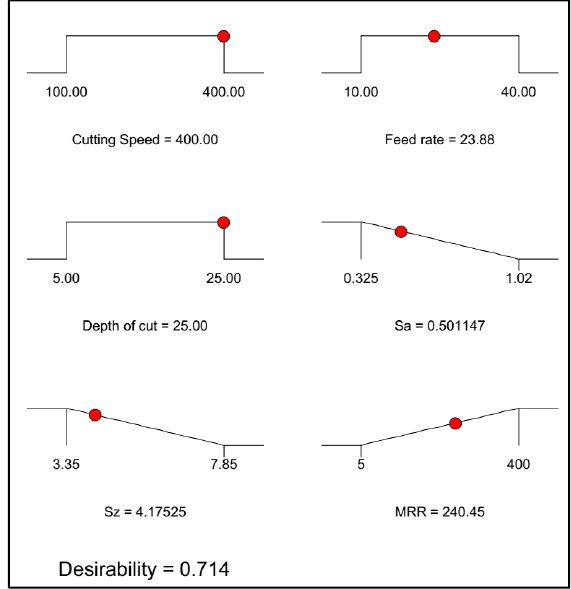
Figure 15. Multi-objective optimization solution as ramp function.